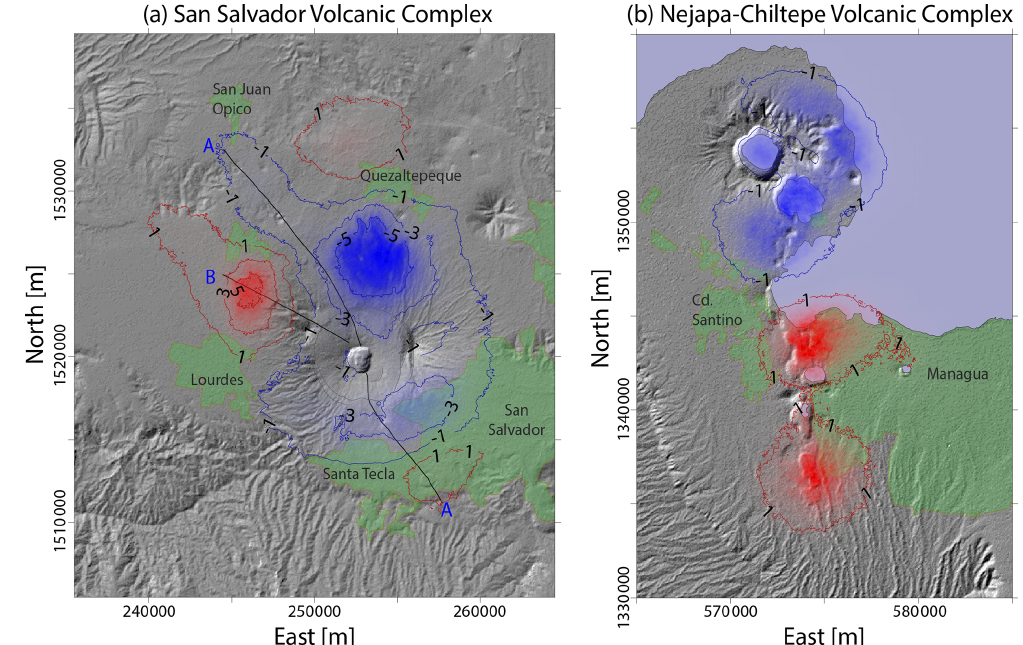
Figure 10. Difference between the probability maps of small-scale PDC inundation presented in Figs. 8 and 9 (mean values), which are derived from the use of thematic vent opening maps, and the equivalent results that would be derived from the application of non-thematic vent opening maps. The inundation probability difference is expressed in percentage. These maps highlight the relevance of using thematic vent opening maps in the assessment of volcanic hazard at volcanoes where eruptive style may significantly change with vent location. (a) San Salvador volcanic complex. (b) Nejapa-Chiltepe volcanic